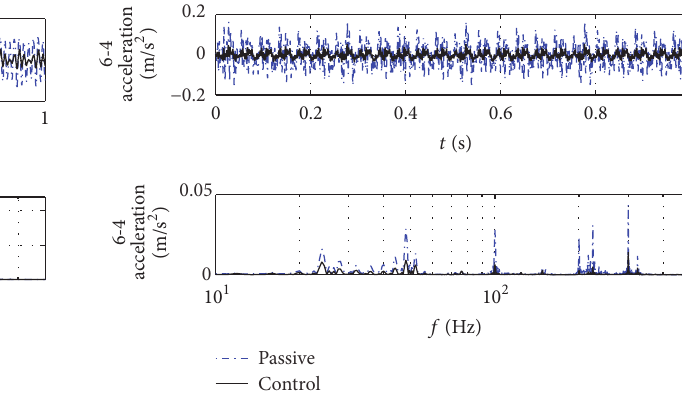
Figure 24: Comparison time-frequency domain curves of acceler- ation response of position 6-2 on the experimental platform before and after being controlled.